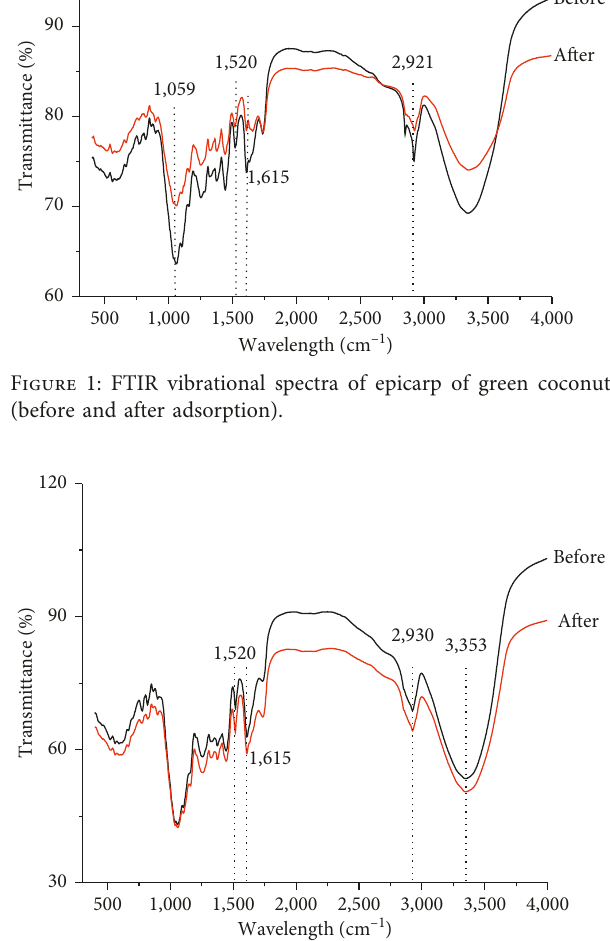
Figure 2: FTIR vibrational spectra of mesocarp of green coconut (before and after adsorption).